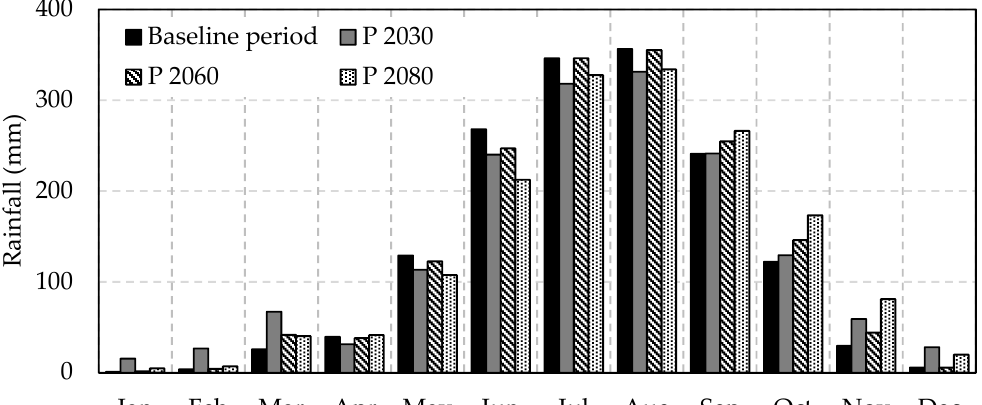
Figure 10. Average monthly rainfall during the baseline period and future time horizons (2030s, 2060s and 2080s) in the Main Beles and Gilgel Beles subbasins.